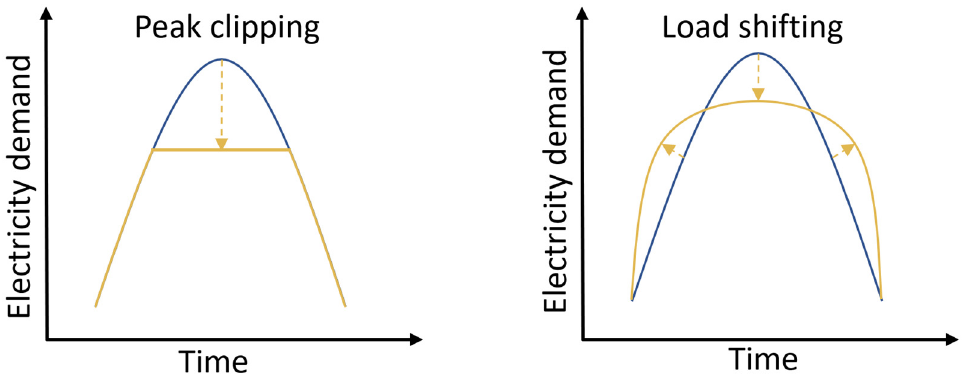
Figure 13. Sum of local objective function costs of the decentralised MPC and objective function cost of the centralised MPC.